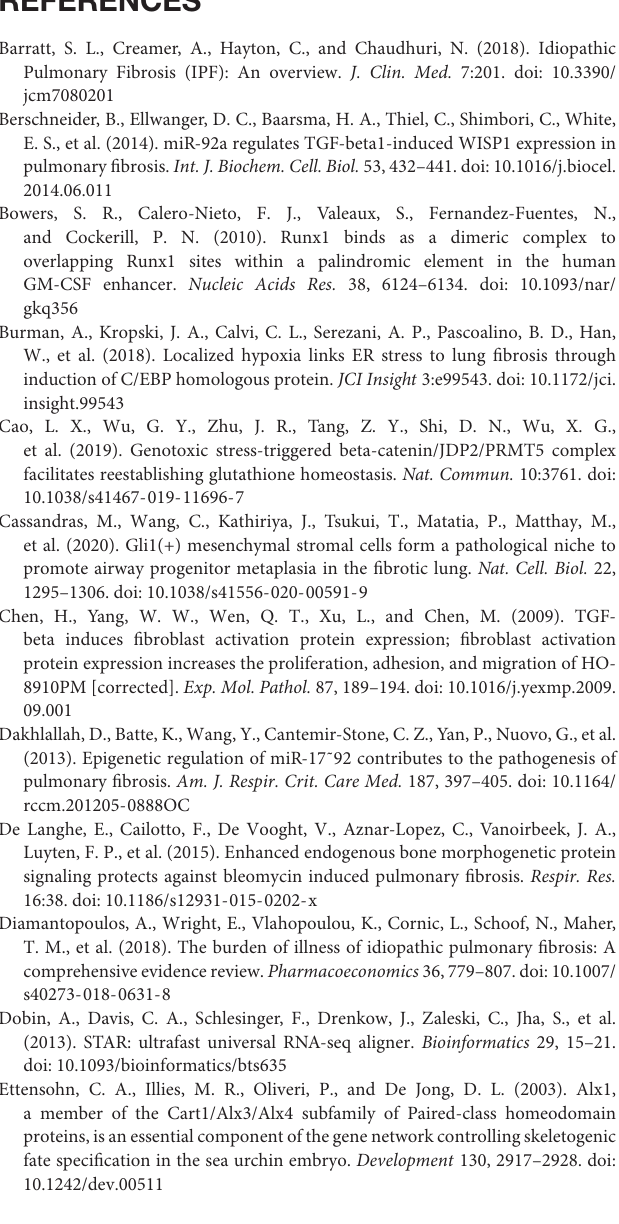
Supplementary Figure 1 | (A) Flow cytometry of human lung fibroblasts treated with TGF β only (vehicle) or TGF β with ASTEX. (B) Phase contract images of HUVECs, treated with TGF β + IL1b only (vehicle) or TGF β + IL1b with ASTEX six days postexposure (scale bar: 100 µ m). Supplementary Figure 2 | Change in animal weight in animals treated with bleomycin (vehicle, DF-EV, or ASTEX) and sham ( n = 5 animals/group). Statistical